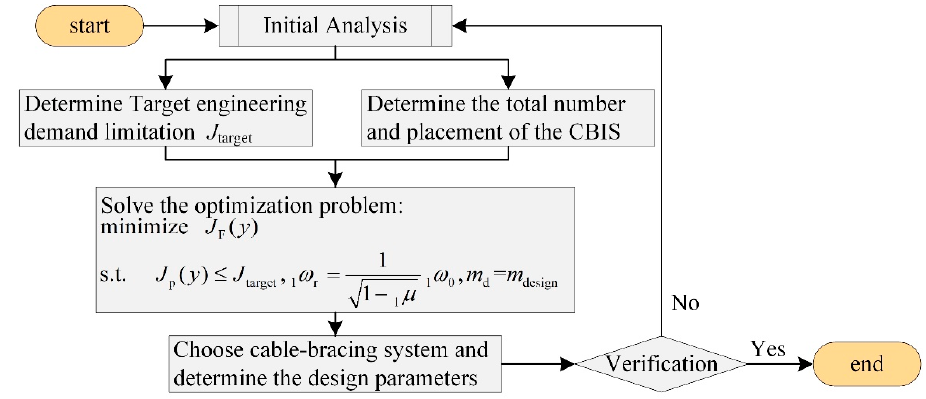
Figure 6. Design flowchart.